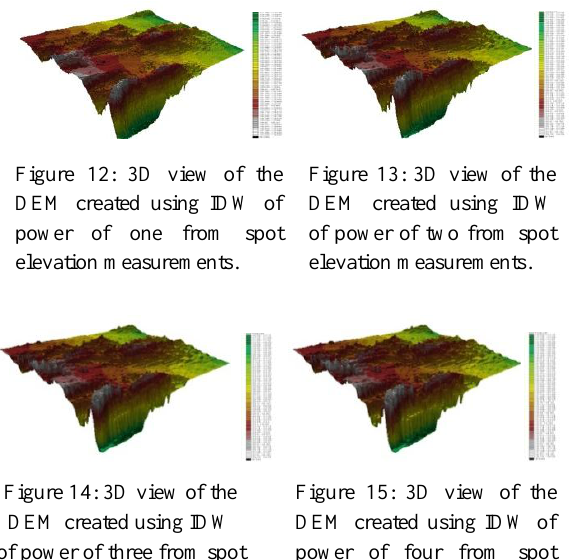
Figure 15: 3D view of the DEM created using IDW of power of four from spot elevation measurements.